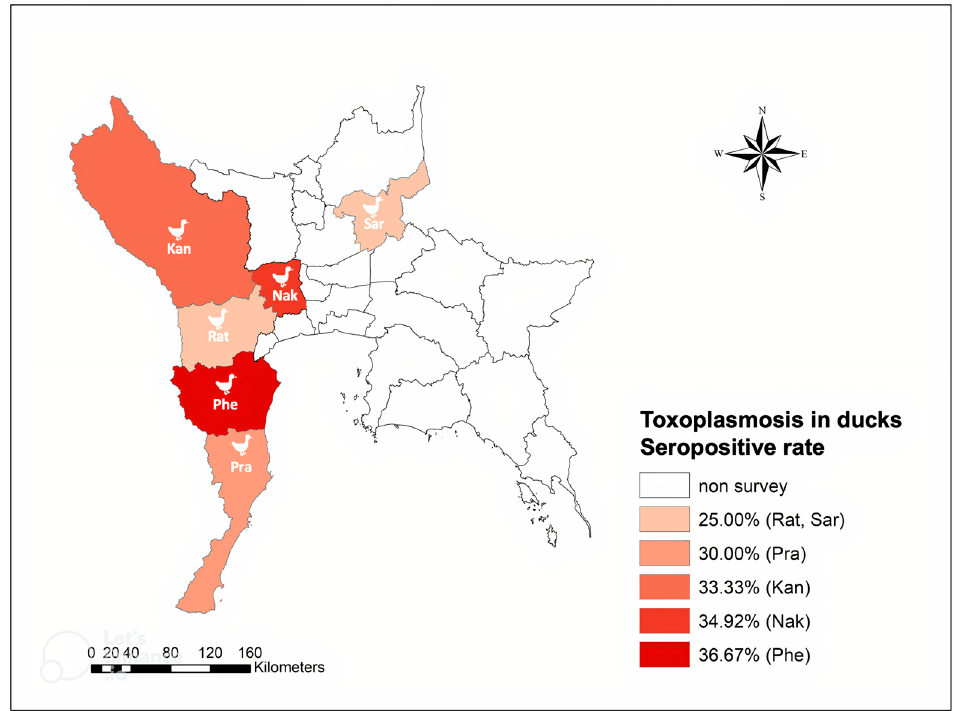
Figure 2. Geographical distribution of T. gondii infection in free-grazing ducks in the central and western areas of